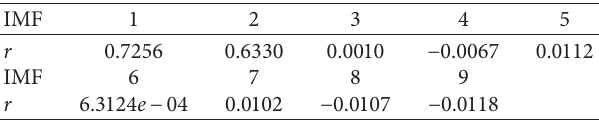
Table 1: Correlation coefficients of each component and original signal.